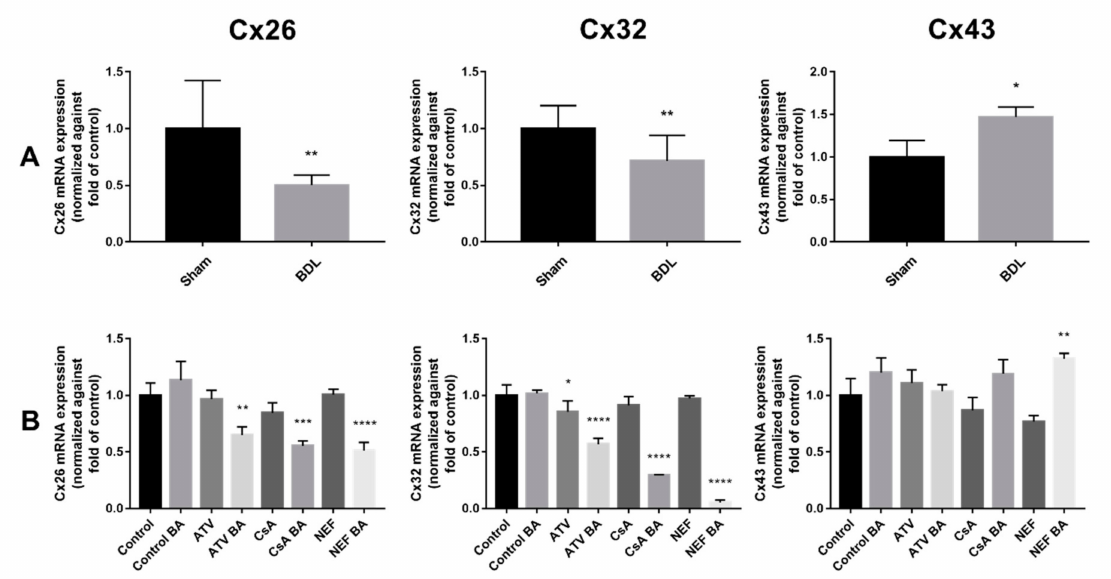
Figure 1. Connexin mRNA expression in cholestasis. Hepatic mRNA levels of Cx26, Cx32 and Cx43 were studied in the liver of cholestatic mice ( A ) and in human hepatoma HepaRG cells cultured in cholestatic conditions ( B ) by RT-qPCR analysis. Relative alterations in mRNA levels were calculated according to the 2 ( − ∆∆ Cq) algorithm. ( A ) Liver sections were obtained from male mice following bile duct ligation (BDL) for 20 days. Data were processed by a parametric student t-test with Welch’s correction or a non-parametric Mann–Whitney test. Data are expressed as means +/ − SD with * p ≤ 0.05 ** p ≤ 0.01 compared to sham-operated animals (Sham n = 12; BDL n = 18) (N = 2). ( B ) Human hepatoma HepaRG cells were exposed to cholestatic drugs either in the absence or presence of a 50 × concentrated mixture of bile acids (BA) for 72 h and compared to untreated human hepatoma HepaRG cells, indicated in the figure as control. Data were processed by a parametric one-way ANOVA followed by post hoc tests with Dunnett’s corrections. Data are expressed as means +/ − SD with * p ≤ 0.05 ** p ≤ 0.01 *** p ≤ 0.001 and **** p ≤ 0.0001 compared to control samples (control n = 3; control BA n = 3; atazanavir (ATV) n = 3; ATV BA n = 3; cyclosporine A (CsA) n = 3; CsA BA n = 3; nefazodone (NEF) n = 3; NEF BA n = 3) (N =